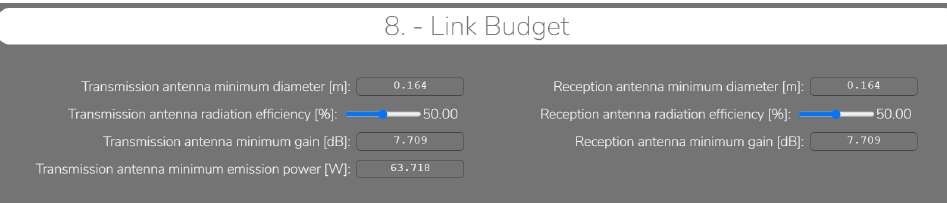
Figure 11. Satellite project link budget step window.